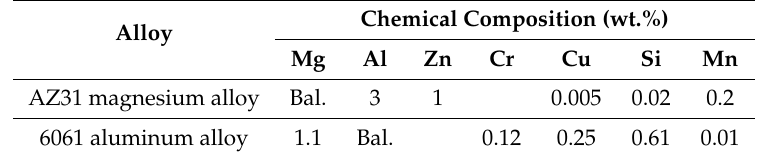
Table 1. Chemical compositions of the AZ31 magnesium alloy and 6061 aluminum alloys. Chemical Composition (wt.%) Alloy Mg